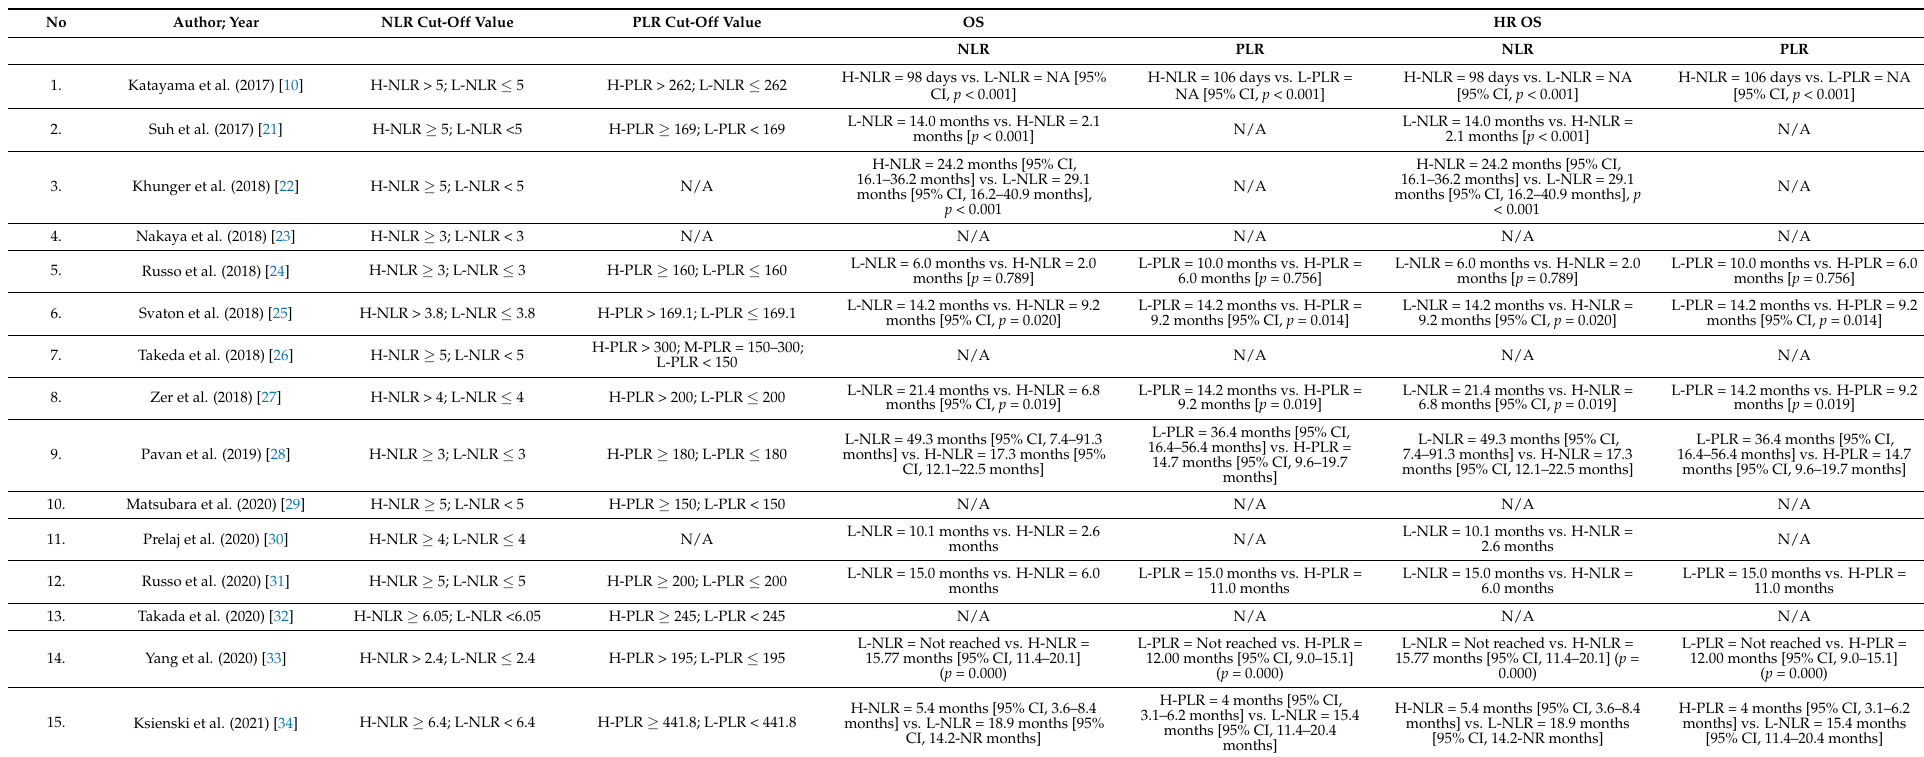
Table 3. Outcomes of included studies (overall